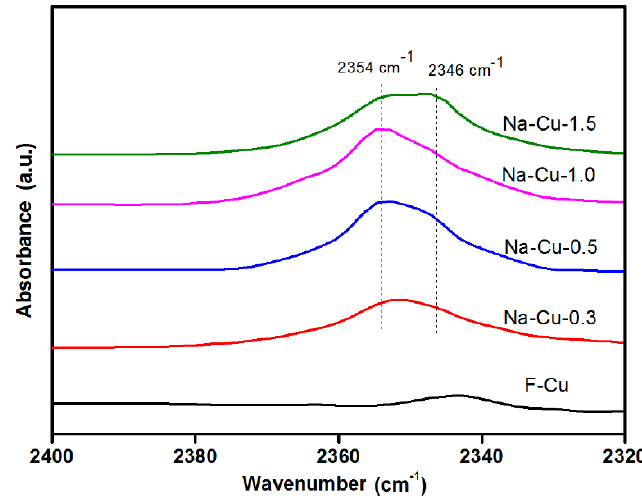
Figure 4. CO 2 -DRIFTs results of fresh and Na-impregnated catalysts.